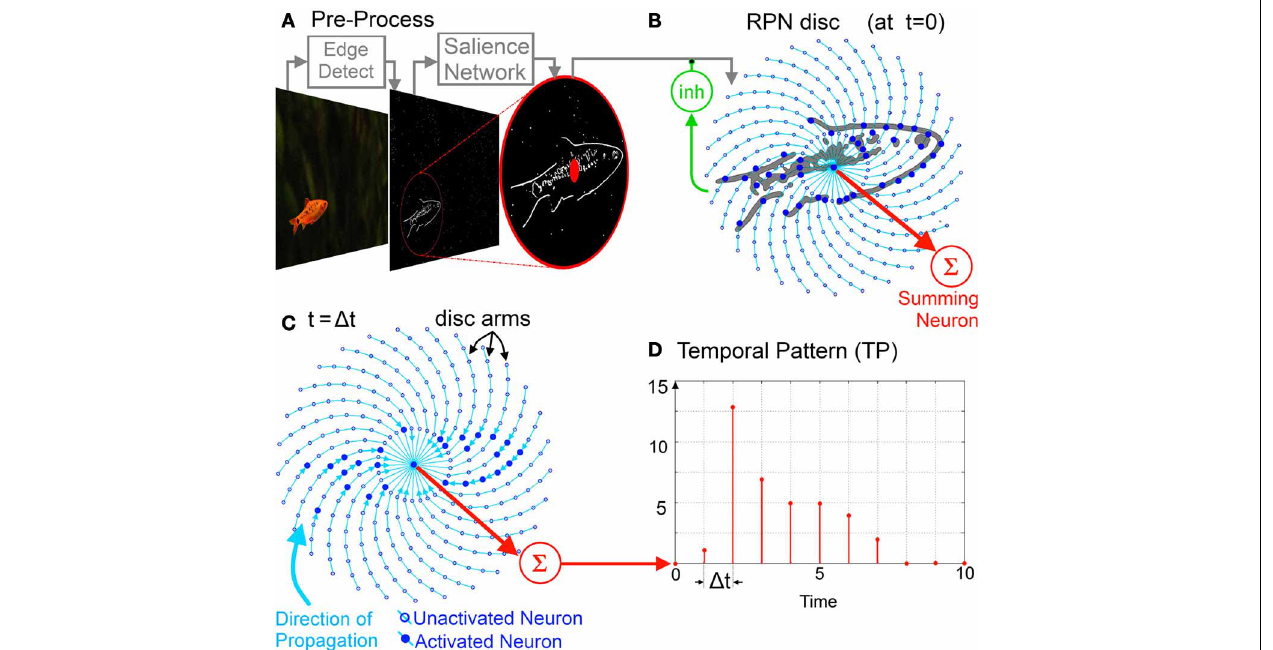
FIGURE 3 | The spiral RPN System Diagram: raw image to TP. (A) Pre-processing stage, from the raw image feature(s) extracted and input to a salience network which detects the most salient region and translates it to the RPN aperture. (B) The image is then projected on to the RPN disc with the RPN taking in one frame at a time via its inhibitory feedback neuron (inh). (C) The projected image is then processed via its unidirectional inwardly